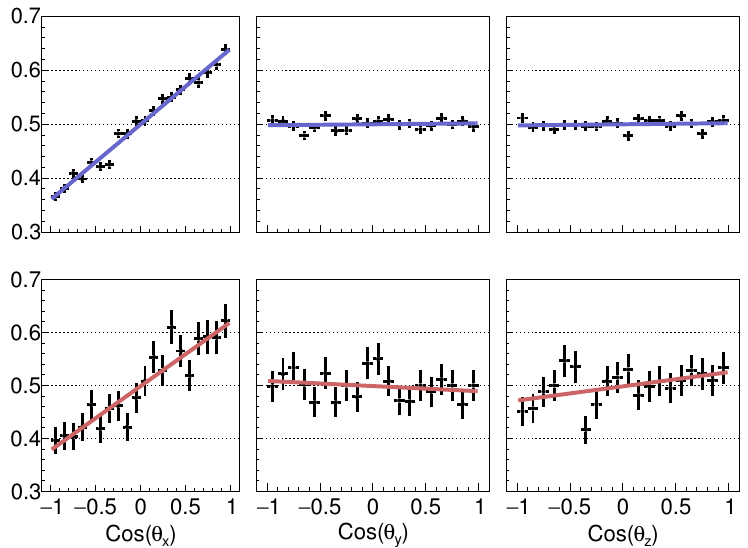
Figure 8 . Angular distribution of the polarized (cid:3) + (cid:18) y , cos (cid:18) z (see eq. (9)). The distributions on the top are for an initial polarization (cid:24) y = (cid:24) z =0 and (cid:24) x = (cid:0) 0.40. The same distributions obtained for the (cid:3) + shown at the bottom.